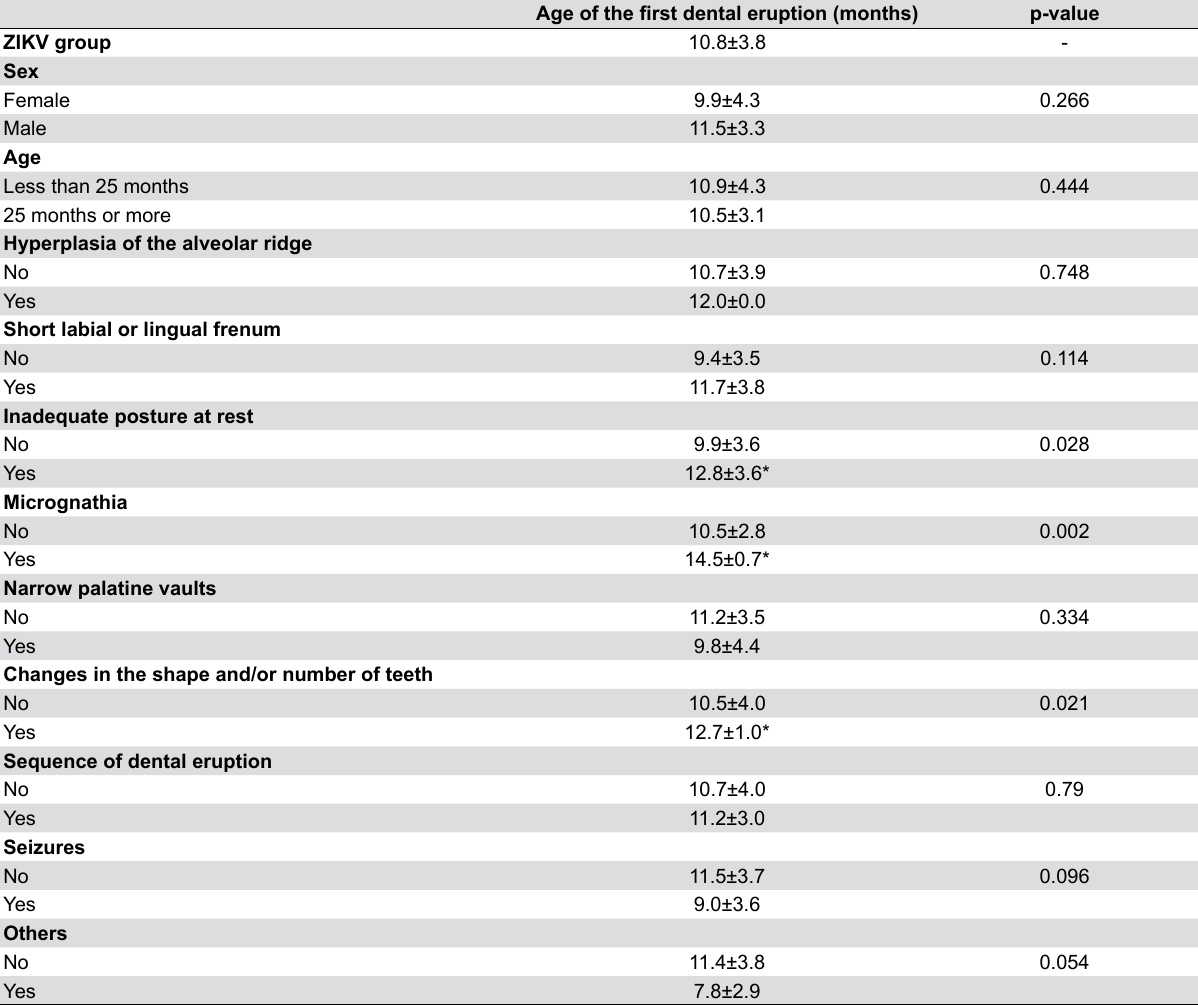
Table 2- Evaluation of clinical characteristics and eruption time in ZIKV